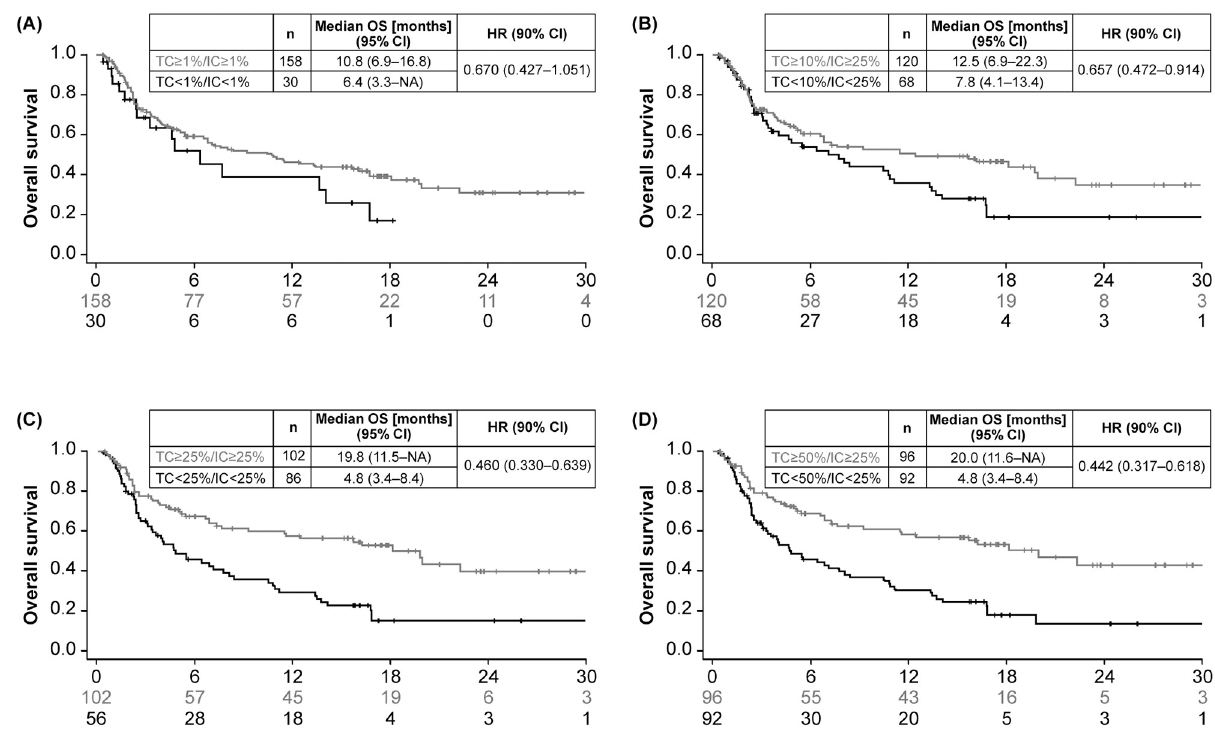
Fig 4. Overall survival in Study 1108 at different cutoffs for PD-L1 expression in tumor cells (TC) or tumor-infiltrating immune cells (IC) with cutoffs of � 1%/ � 1% (A), � 10%/ � 25% (B), � 25%/ � 25% (C), and � 50%/ � 25% (D). CI, confidence interval; IC, tumor-infiltrating immune cell; HR, hazard ratio; NA, not applicable; OS, overall survival; PD-L1, programmed death ligand-1; TC, tumor cell.